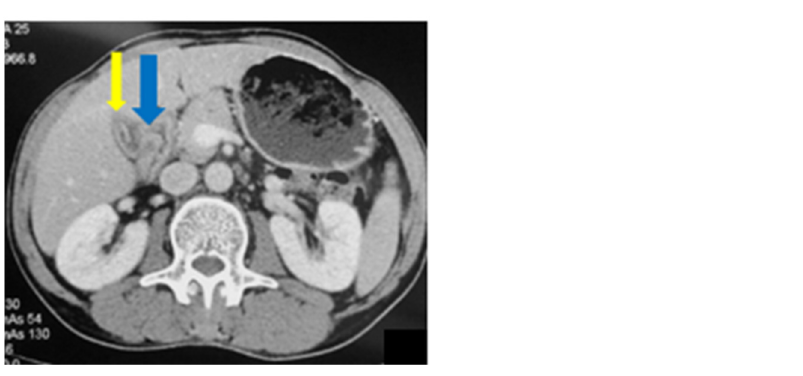
Figure 8. Abdominal CT: mild wall thickening of the gallbladder (blue arrow) with pericholecystic inflammatory changes (yellow arrow).